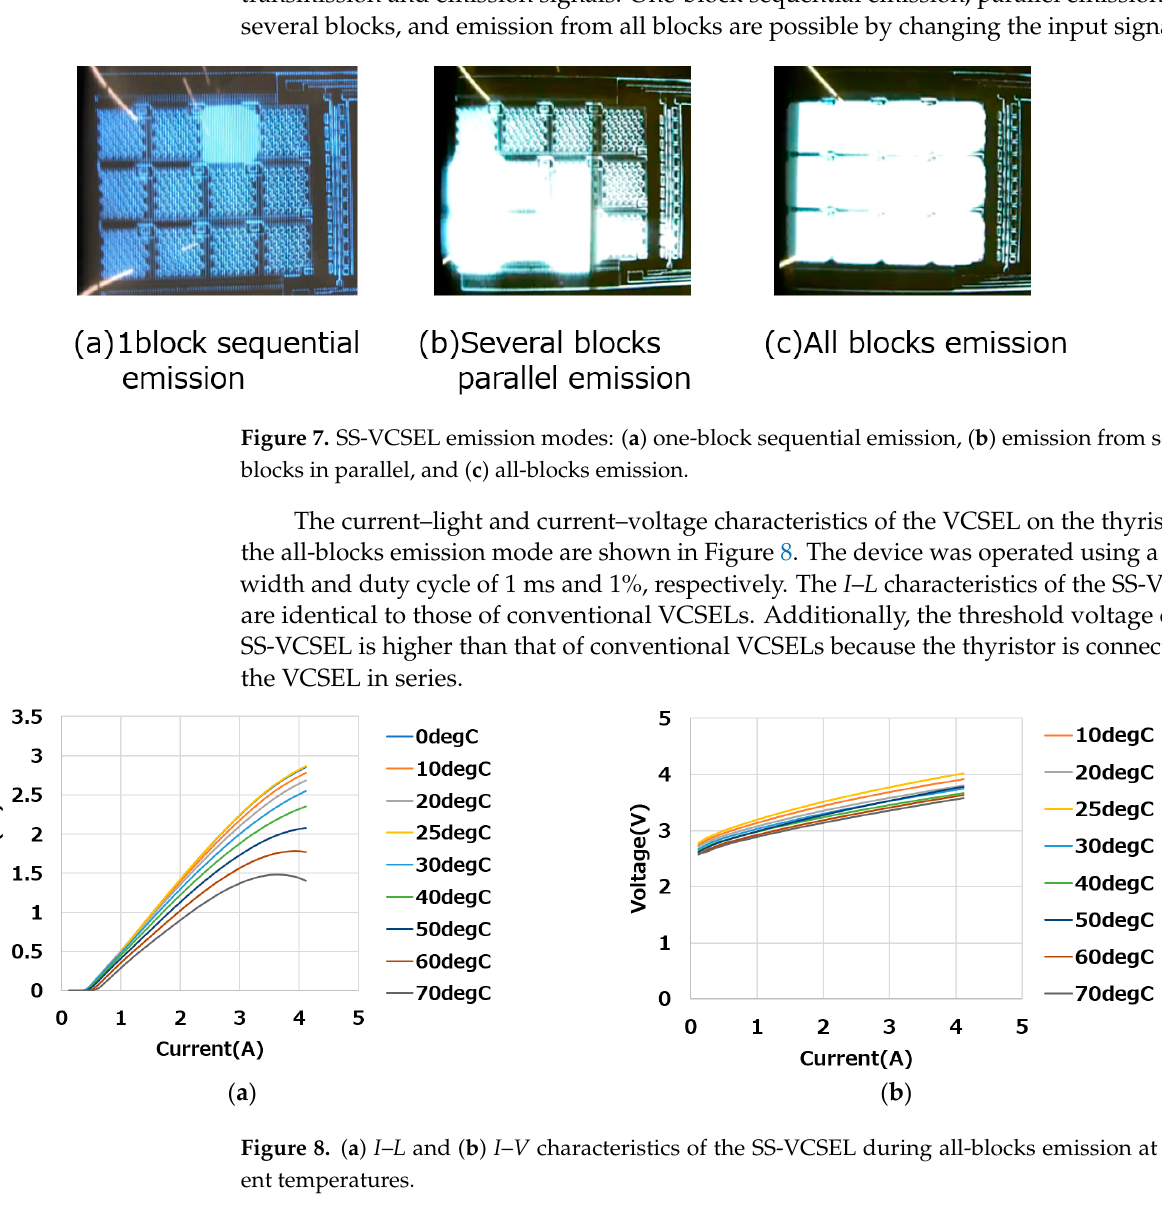
( b ) Figure 9. I – L characteristics of the SS-VCSEL on the Tx module at different temperatures under ( a ) one-block and ( b ) all-blocks emissions; the vertical axis in ( b ) is the output power per block. ( a ) ( b ) Figure 10. Output spectra of the SS-VCSEL on the Tx module at different temperatures under ( a ) one-block and ( b ) all-blocks emissions.